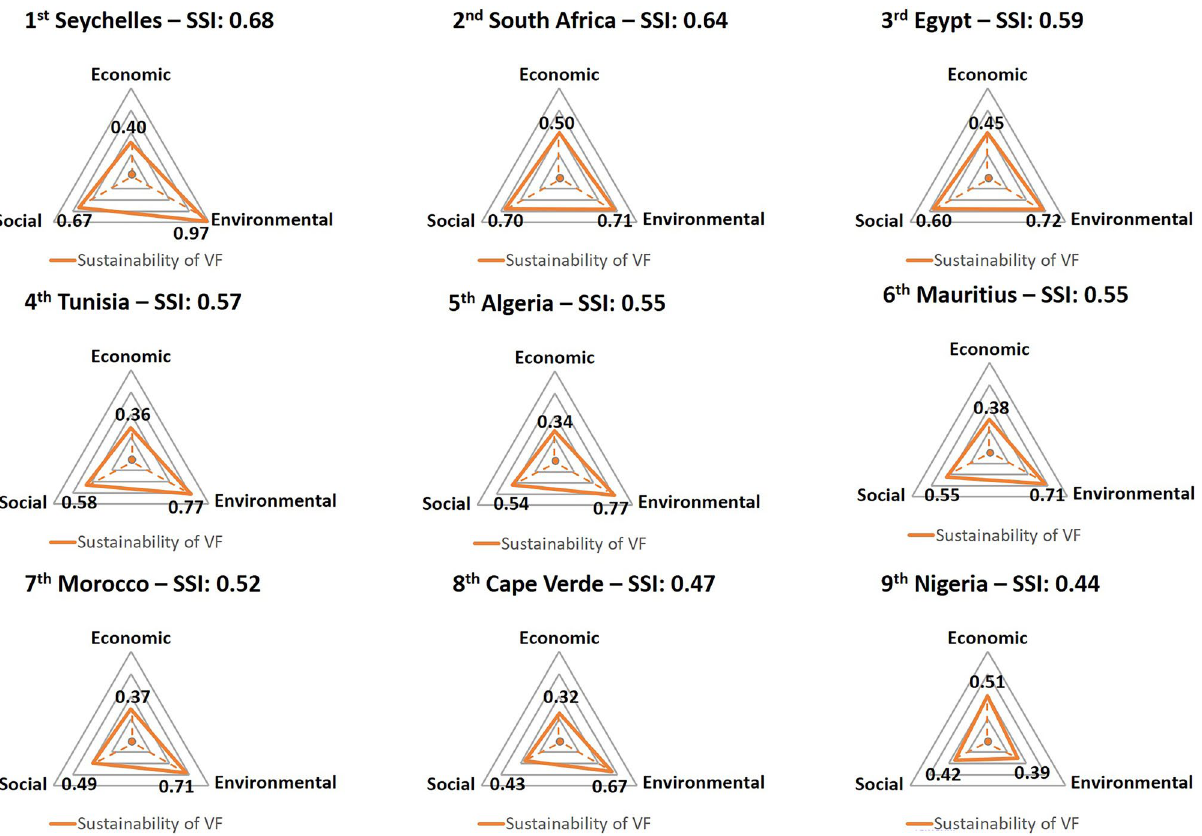
Figure 6. Assessment of the economic, social and environmental sustainability of vertical farming for African countries ranked as ’very favorable’ in the feasibility classification. Final Synthetic Sustainability Index (SSI) calculated as average SFI of Economic ( Economy & Growth , Urban Development ), Environmental ( Energy , Water and Environment ) and Social ( Food Security , Social and Science and Technology